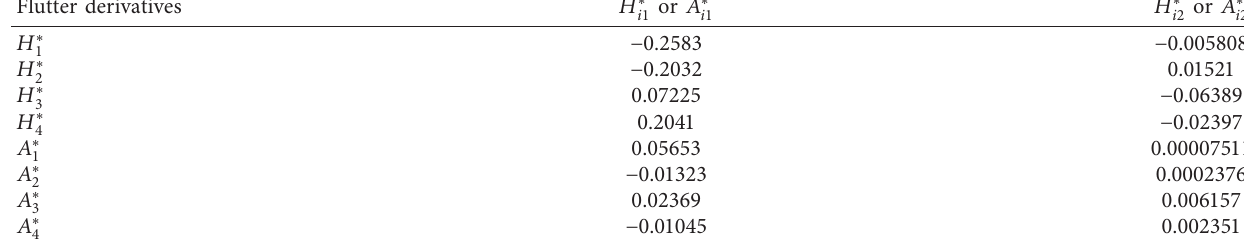
Table 2: Coefficients of flutter derivatives’ function.